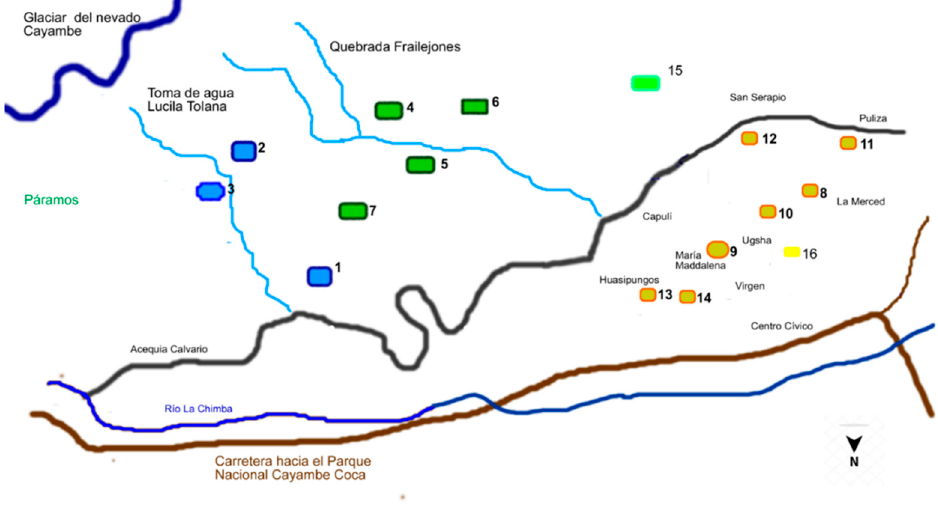
Figure 8. Location of the reservoirs along the hydrosocial territory of La Chimba.